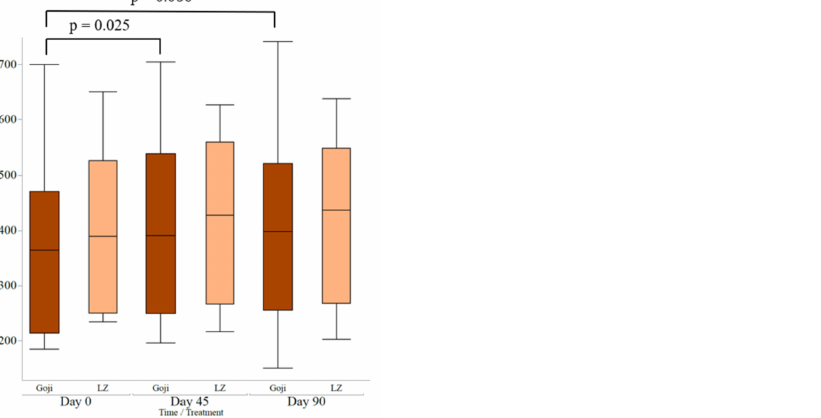
Figure 3. Three months of goji berry intake increased skin carotenoid score at Day 45 and Day 90 compared to Day 0. No changes in the lutein and zeaxanthin supplement (LZ) group were noted. Statistical analysis performed by mixed models using time and treatment as the main factors, and age and sex as the covariates with student t -test for pairwise comparisons; boxplots are the median and interquartile